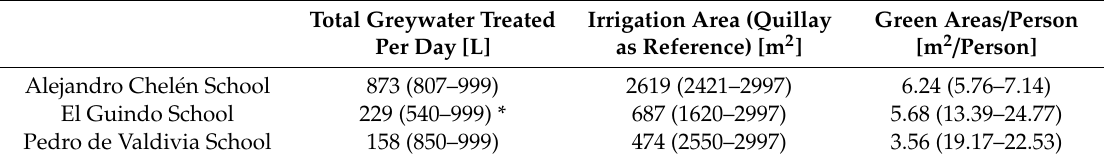
Table 6. Potential irrigation of green areas with current levels of treated greywater and the first range of economic